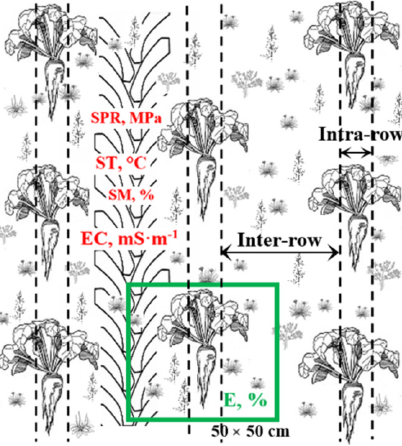
Figure 2. Experimental design: SPR—soil penetration resistance (MPa); ST—soil temperature (°C); SM—soil moisture (%); EC—soil electrical conductivity (mS·m − 1 ); E—effectiveness of weed control systems (%).